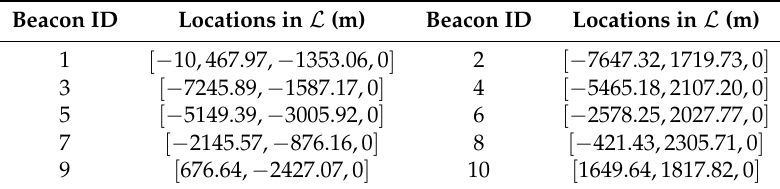
Figure 7. Control profiles of the designed trajectory in the simulation scenarios: ( a ) Triaxial specific force profile in the B frame. ( b ) Triaxial angular rate profile in the B frame. Table 1. The true locations of all ground beacons.